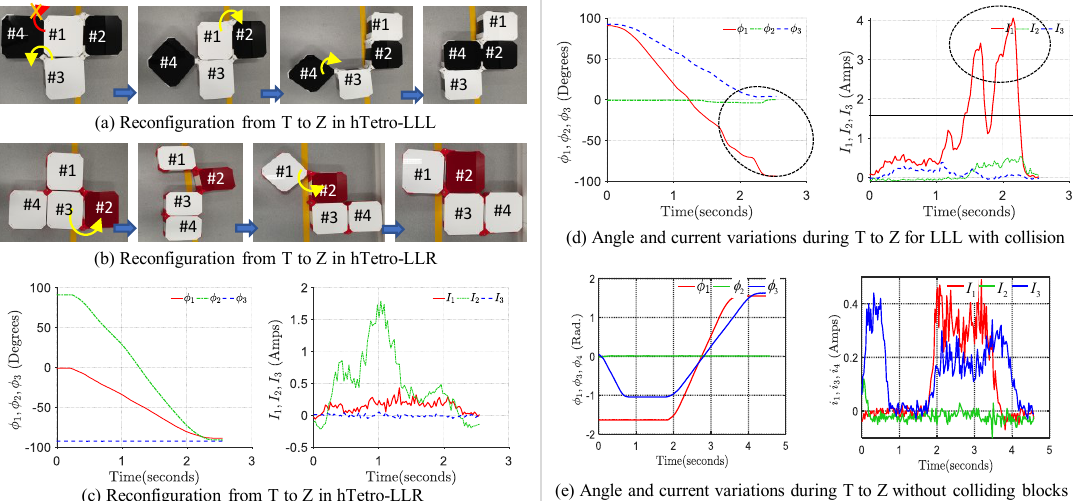
Figure 13. Reconfiguration during T to Z for hTetro-LLL and LLR. The experimental video referred in